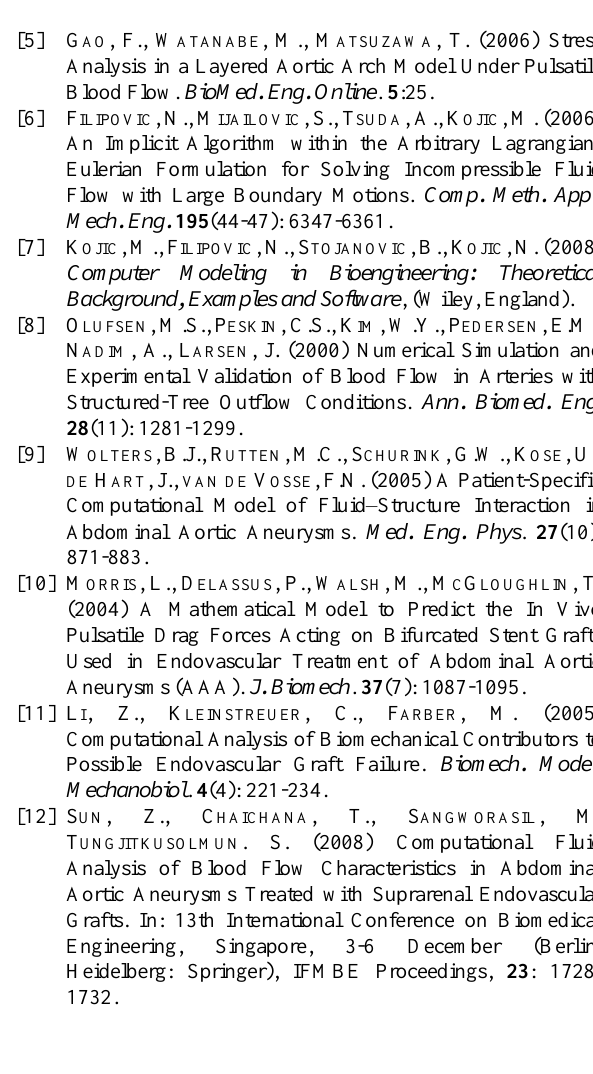
Figure 4. Case B: Velocity field (Units: m/s ), Pressure (Units: Pa ) and Shear stress (Units: Pa ) distribution,